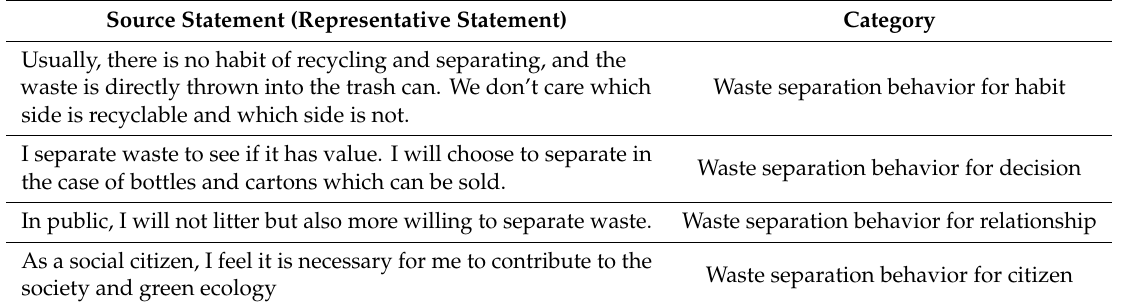
Table 3. Process and results of open coding for waste separation behavior.